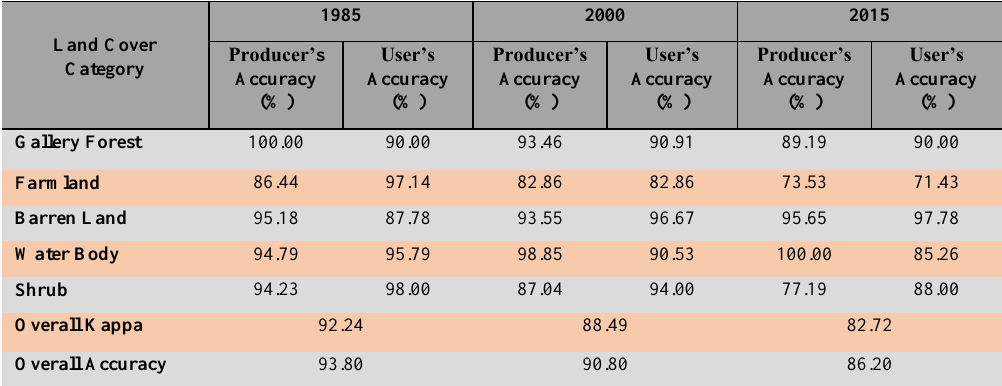
Table 2: Classification accuracies with overall kappa